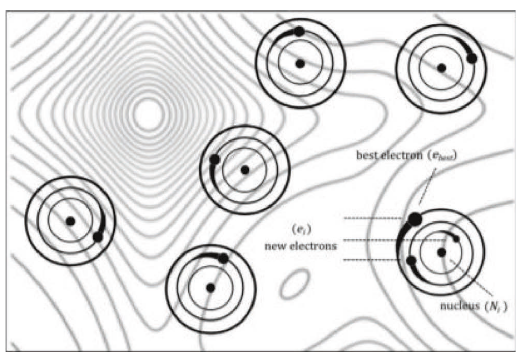
Figure 4: State diagram of orbital transition.